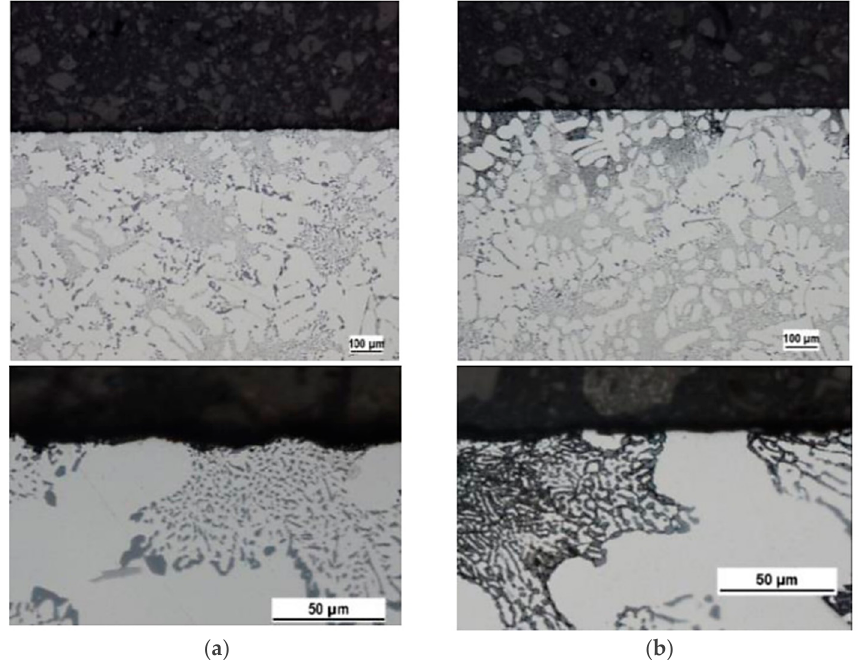
Figure 8. Corrosion attack of AlZn10Si8Mg cast alloys, etch. Dix-Keller. ( a ) alloy D with 0.150% Fe; ( b ) alloy E with 0.559% Fe.